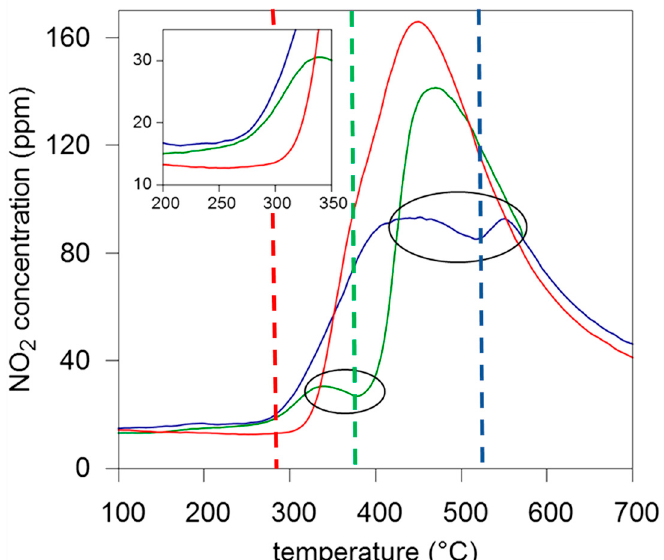
Figure 5. Temperature programmed oxidation (TPO) profiles of NO 2 evolved from CZ/C mixtures at different mixing condition under NO+O 2 gas flow: CZ(l) (blue), CZ(t) (green) and CZ(m) (red). Dotted lines indicate Tp of carbon oxidation (from red line in Figure 4).